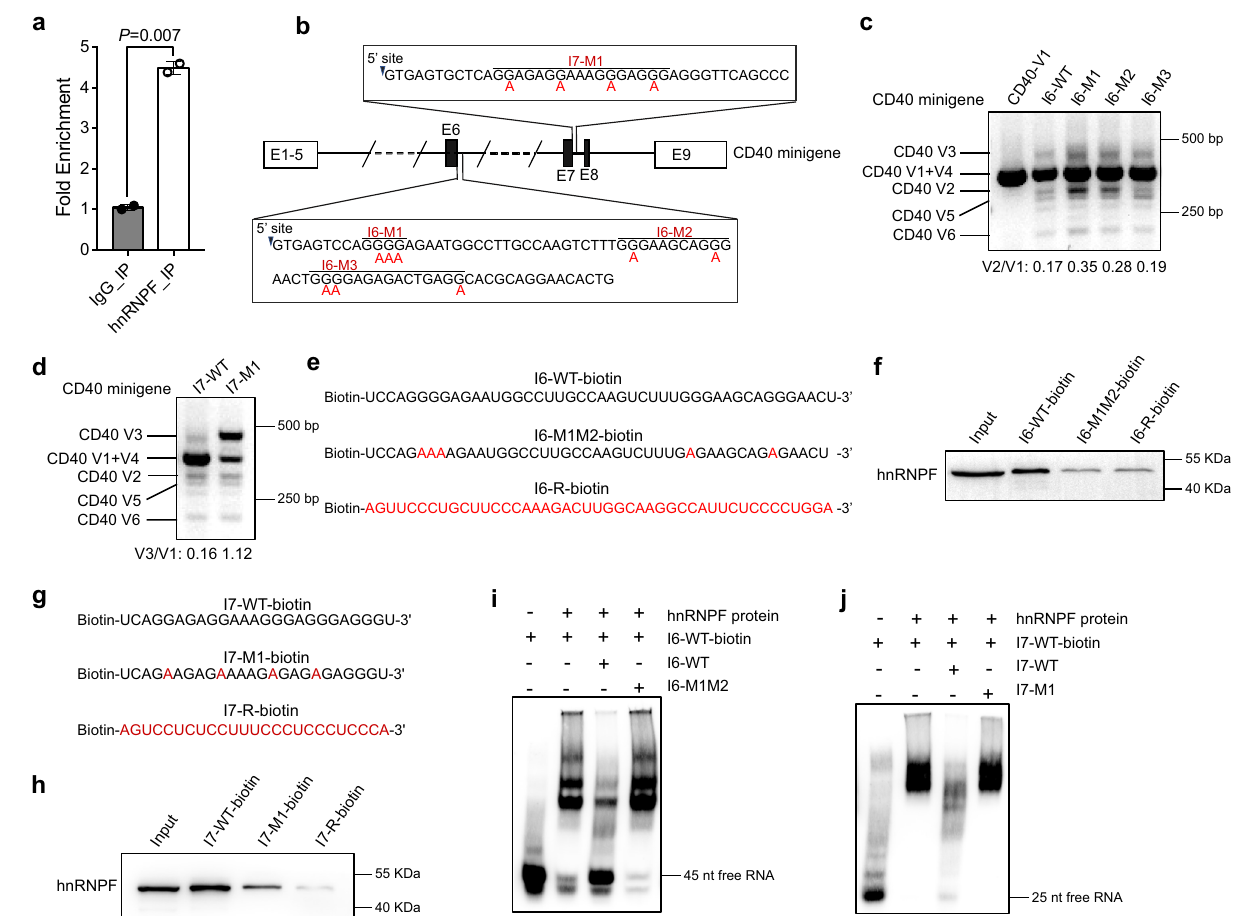
Fig.7|hnRNPFdirectlybindstoG-tractsof Cd40 pre-mRNAtomodulateexon inclusion and intron removal. a RIP-qPCR analysis of the enrichment of Cd40 gene bound to hnRNP F in WT splenic B cells ( n =2). Data are from one single experiment. An unpaired two-tailed Welch ’ s t test was used for statistical analysis. Data are presented as mean values ± SD. b Illustration of Cd40 minigenes. Filled boxes: alternatively spliced exons. Empty boxes: constitutively spliced exons. The mutated bases were highlighted in red. c , d RT-PCR analysis of Cd40 variants, including exon 6 skipping ( c ) and intron 7 retention ( d ), using primer P1 and P2 in 3T3-L1cellstransfectedwithWTormutated Cd40 minigenesasindicated.CD40V1